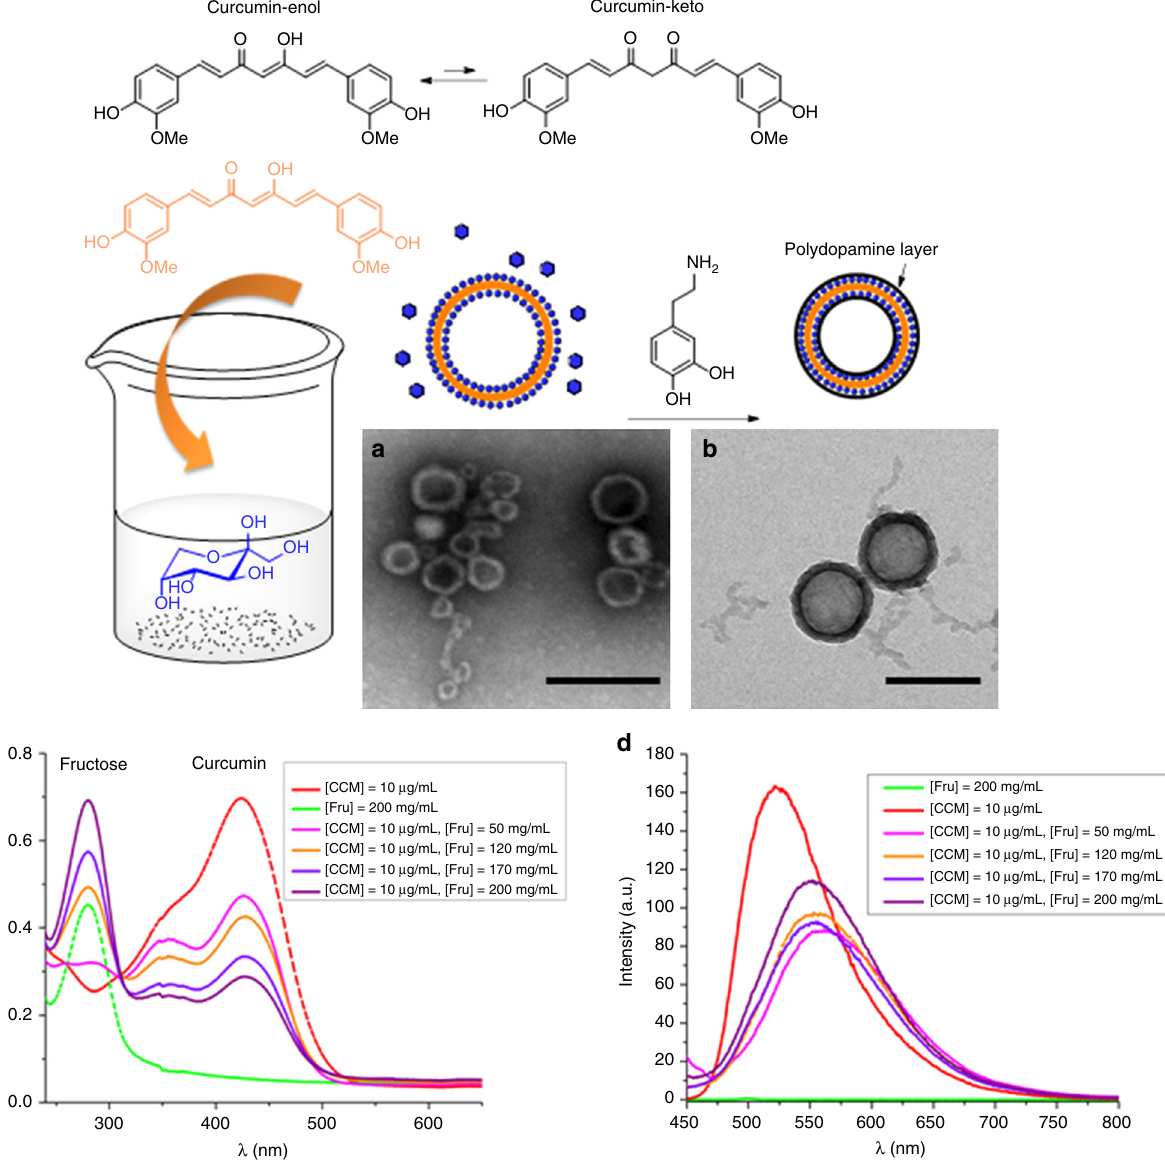
Fig. 1 Formation of curcumin-based capsules induced by the presence of sugar and their stabilization using dopamine. The transmission electron microscope (TEM) micrographs show a the particles obtained using [Fructose, Fru] = 10 mg/mL, [Curcumin, CCM] = 60 μ g/mL (stained with uranyl acetate, scale bar is 200 nm) and b the particles after the formation of a stabilizing polydopamine layer (scale bar is 200 nm), c UV – Vis and d fl uorescence spectra of curcumin, fructose and curcumin/fructose mixture in 3 μ g/mL can fully dissolve in the fructose aqueous solution without the formation of any obvious aggregates. Once the cur- cumin concentration reached the critical threshold of 3 μ g/mL, fructose and curcumin start to aggregate to form nanoparticles. The formation window spans from a critical curcumin con- centration of around 3 to 80 μ g/mL. Within the window of nanoparticle formation, the observed hydrodynamic diameters were constant and not signi fi cantly dependent on the fructose or curcumin concentrations. However, high fructose concentration tends to limit assembly of curcumin by inhibiting its dispersion and results in its precipitation (Supplementary Figure 2). Although minute amounts of DMSO were used in the process, the outcomes are independent from the type of solvent as other solvents such as ethanol, tetrahydrofuran or acetone result in similar outcomes (Supplementary Tables 2 and 3).